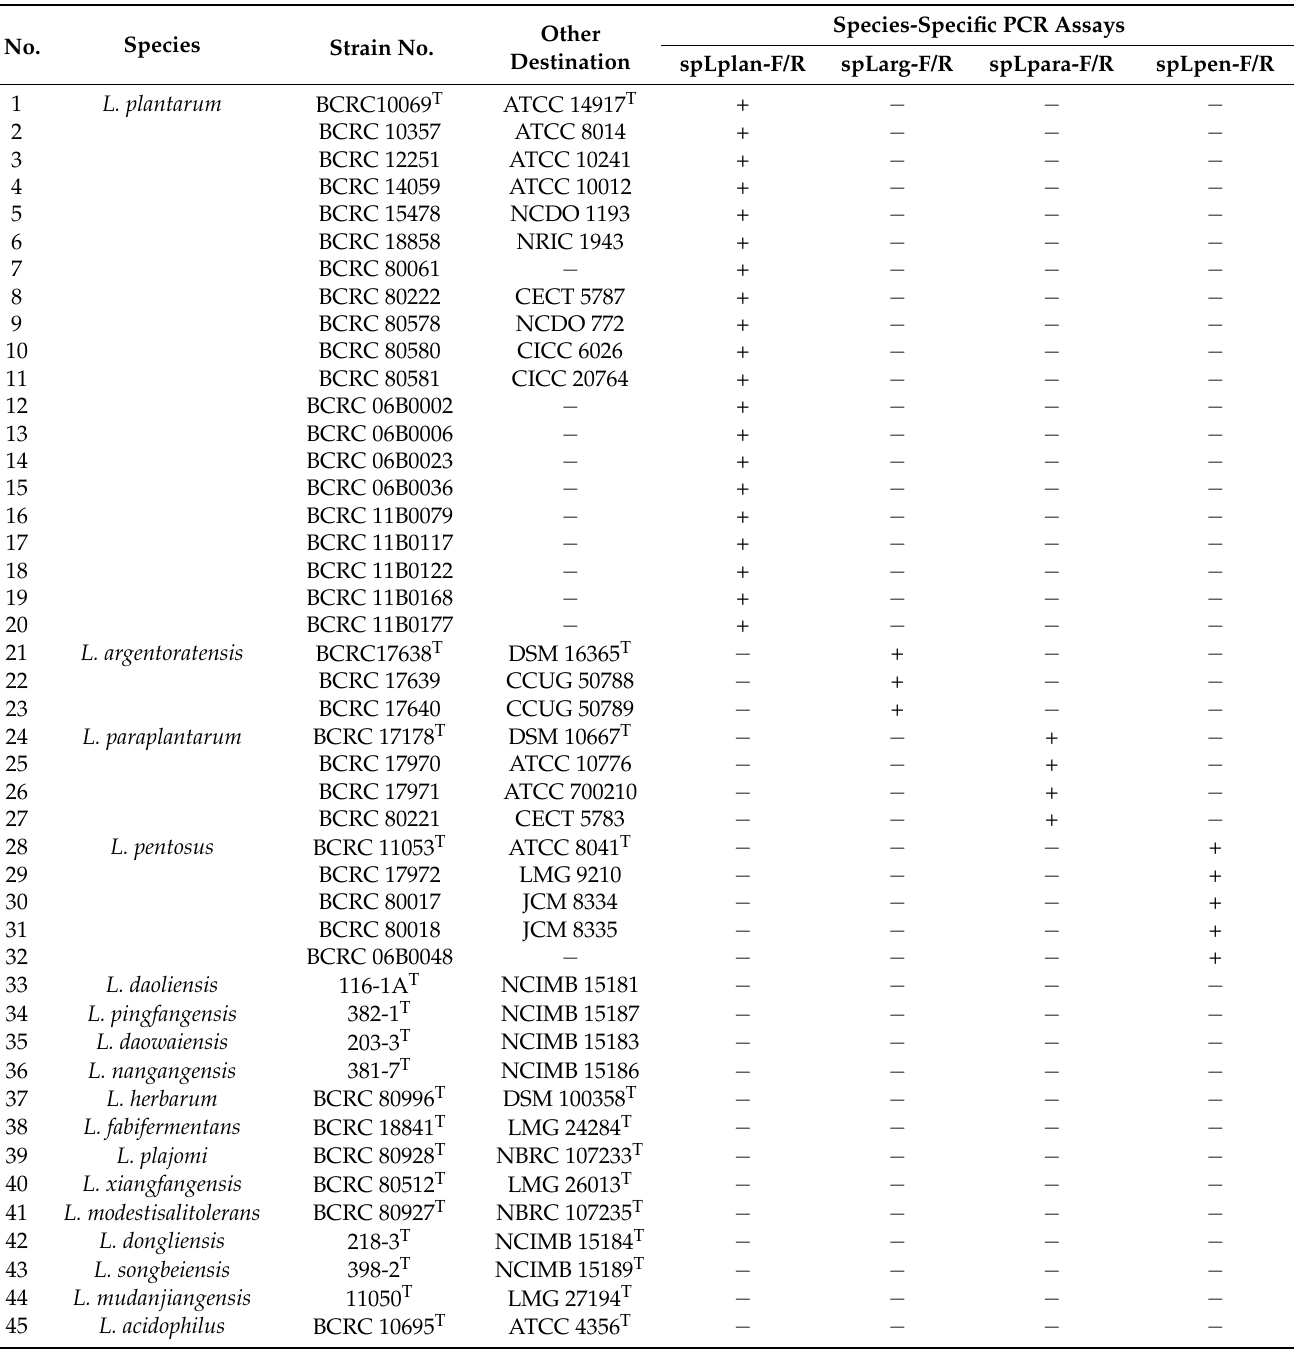
Table 1. Strains used in this study and specificity tests with mutL -targeting PCR